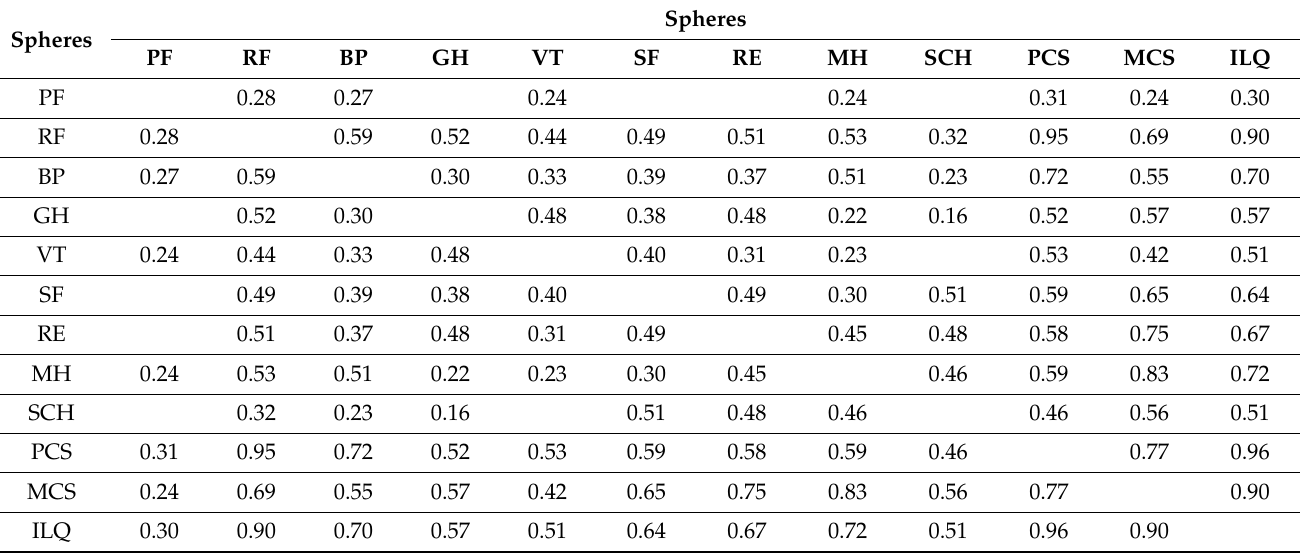
Table A5. Correlations of SF-36 spheres for the age group of >80 years (Spearman’s r